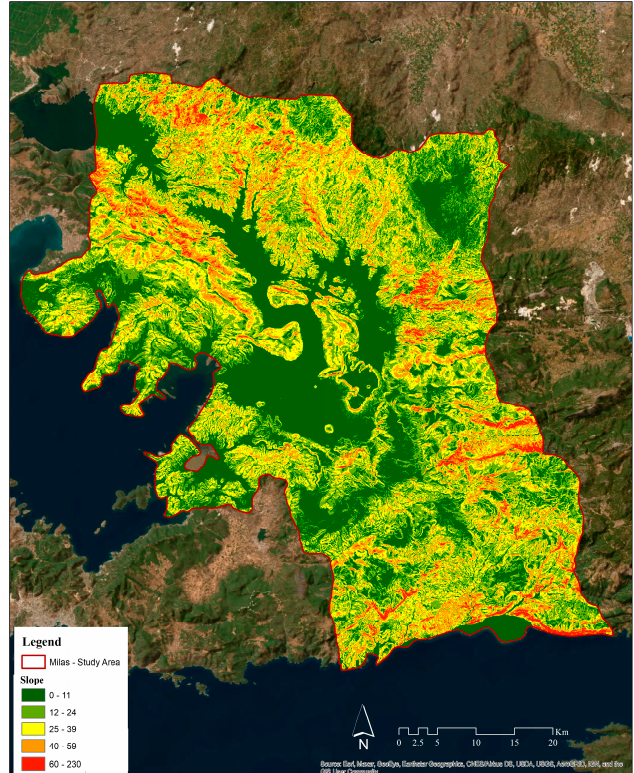
Figure 14. Slopes (%).